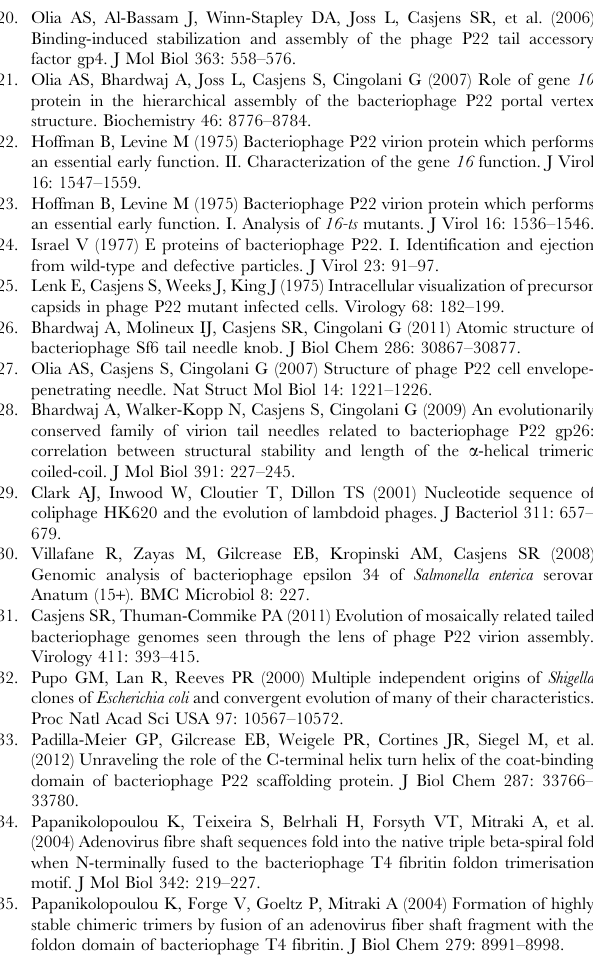
Figure S1 Relationship of host bacterial species to P22-like phage tail needle tip domain type.